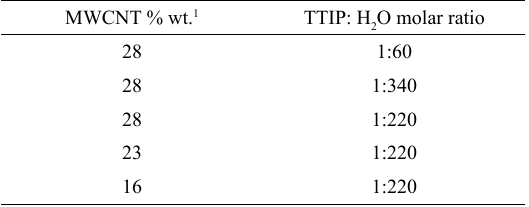
Table 1. Relative proportion of MWCNT, TTIP and H -coated MWCNT. produce TiO 2 MWCNT % wt. 1